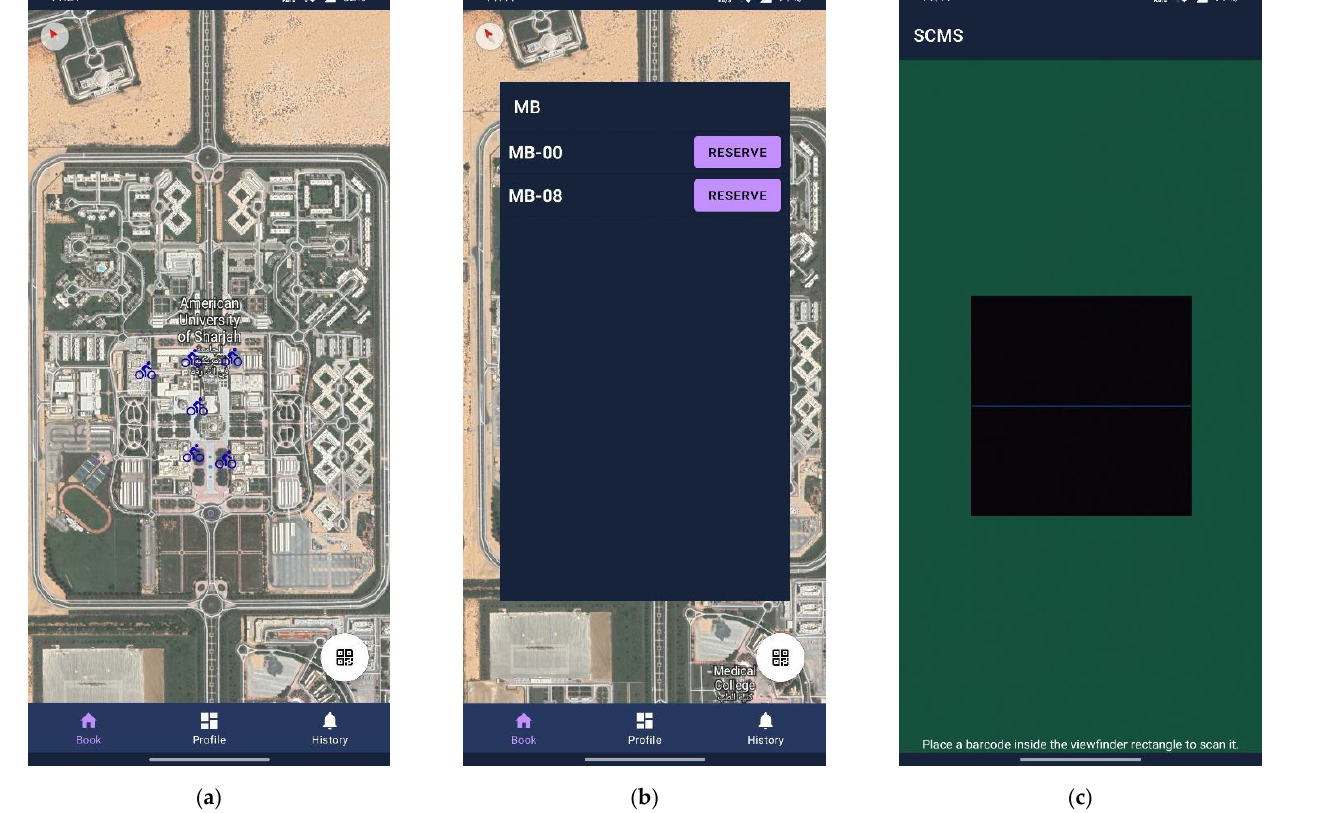
Figure 12. User Mobile Interface ( a ) Map of Campus with charging stations. ( b ) Reserve an e-bike interface. ( c ) QR code scanner.